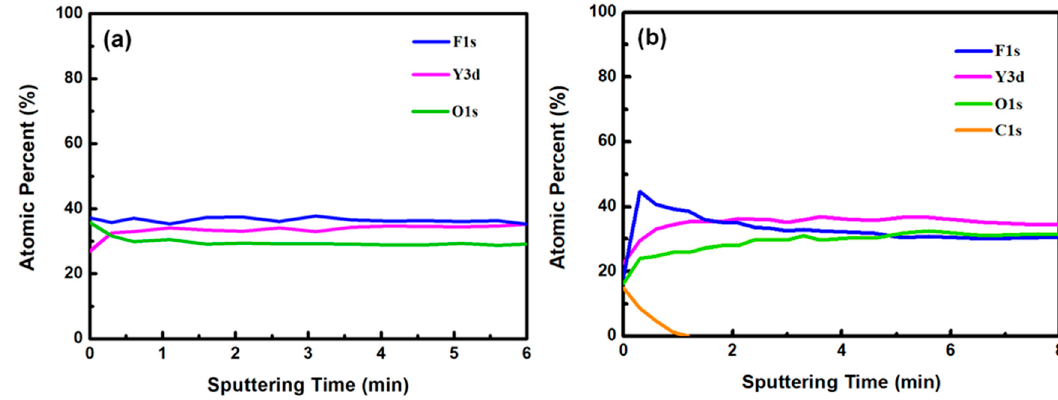
Figure 4. Atomic percentages of YF 3 film versus sputtering time ( a ) before and ( b ) after surface exposure to CF 4 /O 2 plasma.